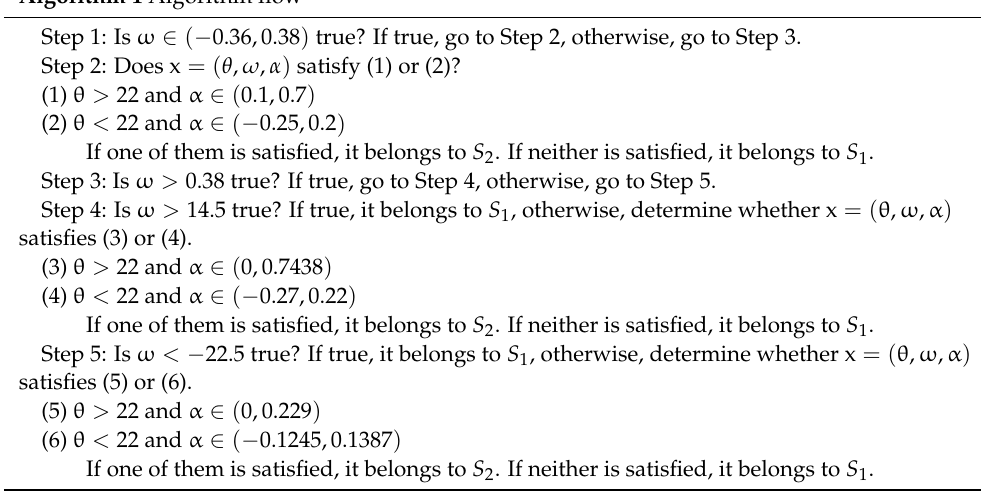
Algorithm 1 Algorithm